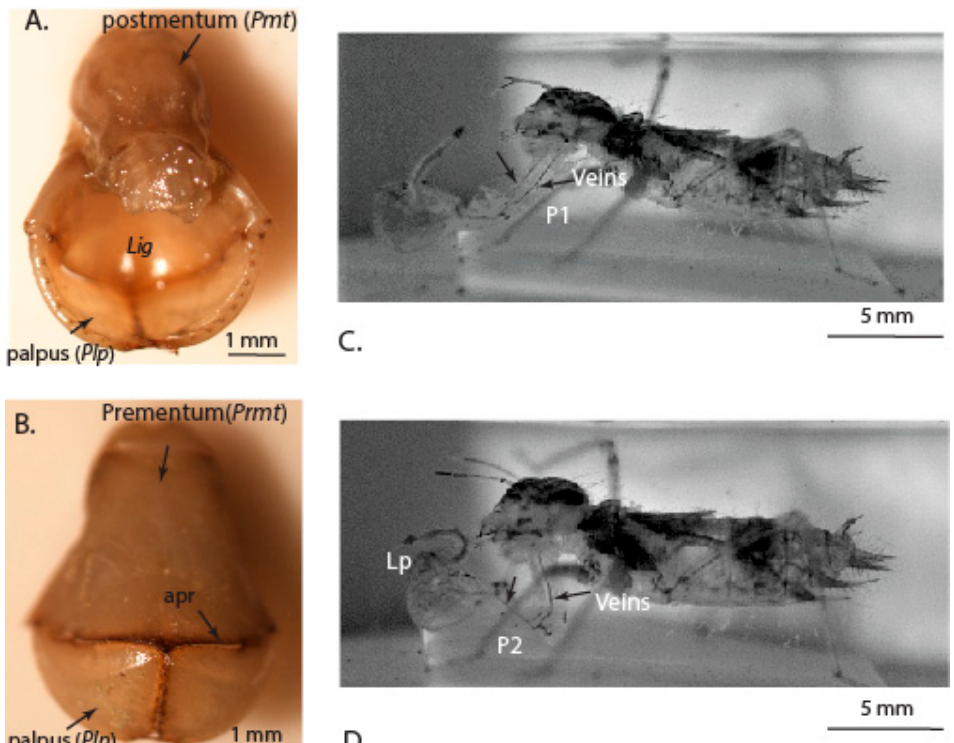
Figure 1. Images showing the labium. ( A ) Dorsal view with Ligula and palpi; ( B ) Ventral view with palpi and apr , apico-premental ridge; and ( C ) view of protracted labium and ( D ) view of the labium during retraction after the prey is captured.